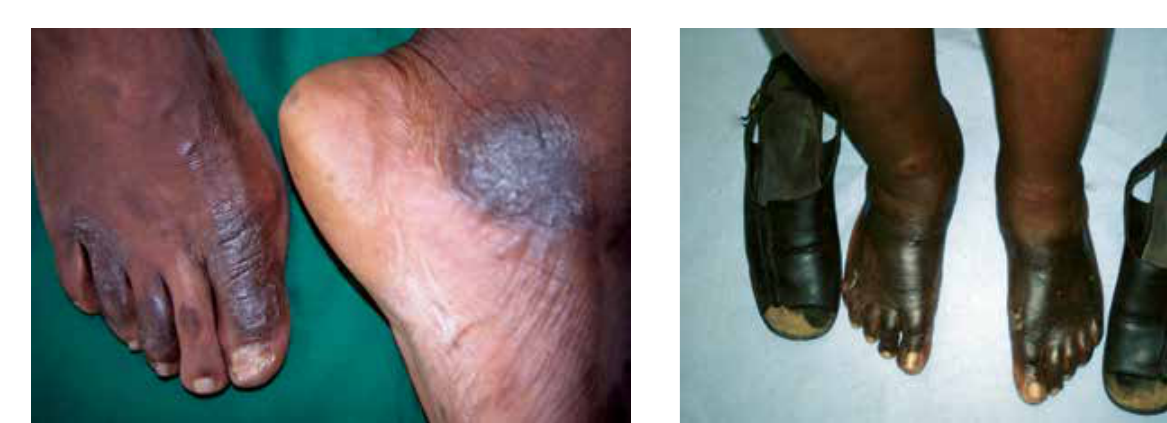
Figure 1: Chronic eczema on the feet Figure 2: Contact dermatitis due to leather